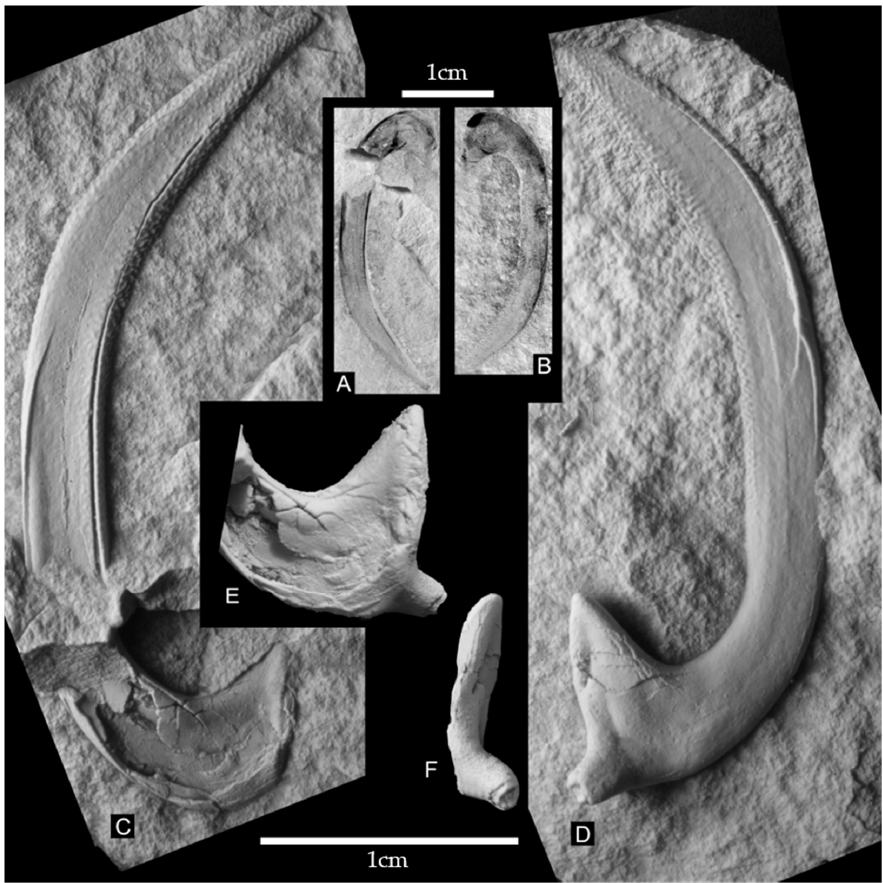
Figure 2. ( A , B ) Fossil imprints MGUS/Sz.1942b and 1942a respectively; ( C , D ) Silicone molds of imprints; ( E , F ) Composite silicone cast of base. ( A , C , E ) Views from abprocessal side; ( B , D ) views from adprocessal side; ( F ) bottom side. ( C – F) Whitened by MgO. Scale bars, 1 cm: upper for ( A , B ); lower for ( C – F ).